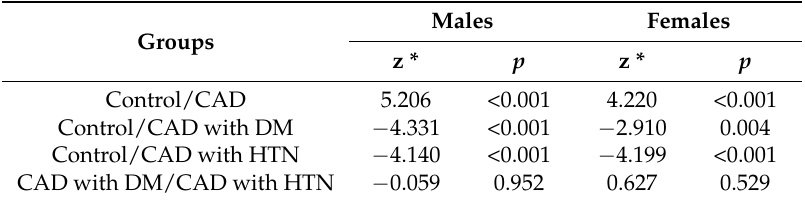
Table 1. Statistical evaluation of frequencies of homozygous recessive characteristics between groups in males and females.